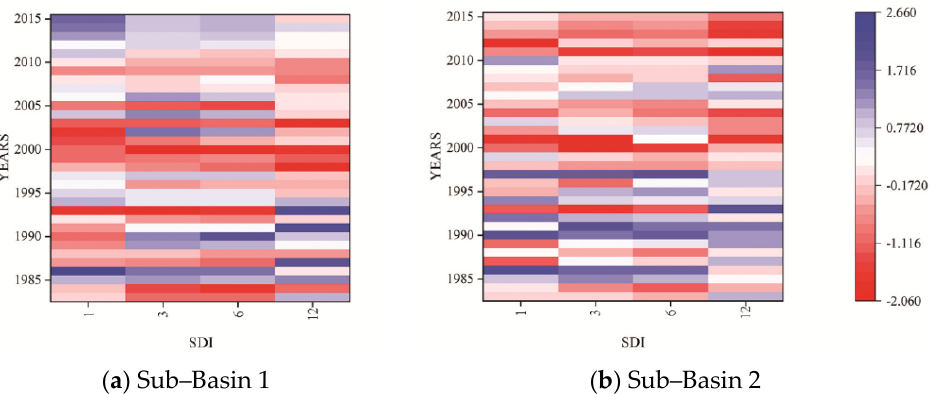
Figure 4. Temporal variation of hydrological drought periods in sub-basins 1 and 2 at different time scales.